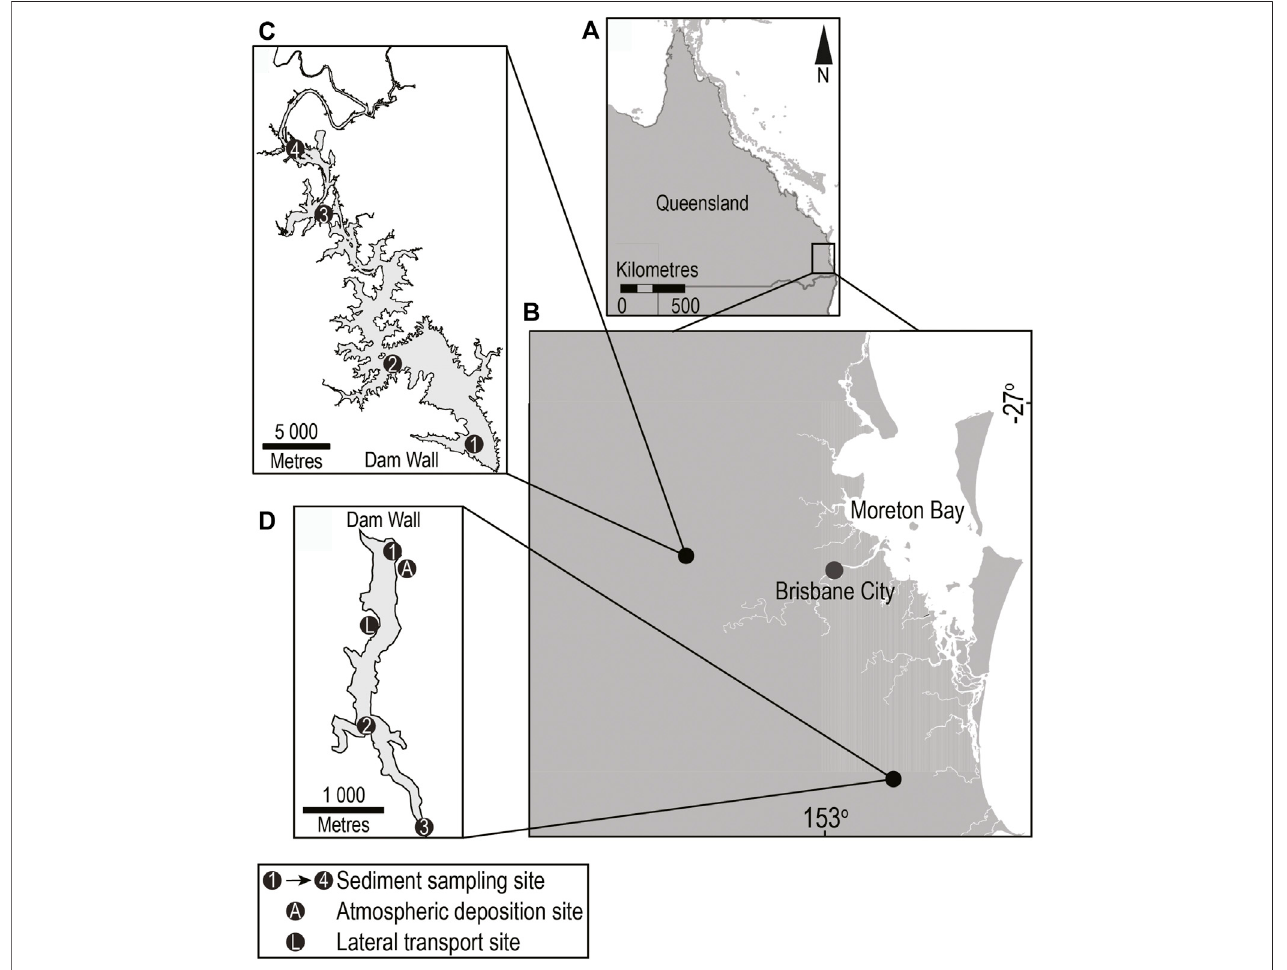
FIGURE1| Studyarearelativeto (A) Queensland,Australiaand (B) SouthEastQueenslandshowinglocationofsamplingsiteson (C) LakeWivenhoeand (D) Little Nerang Dam.